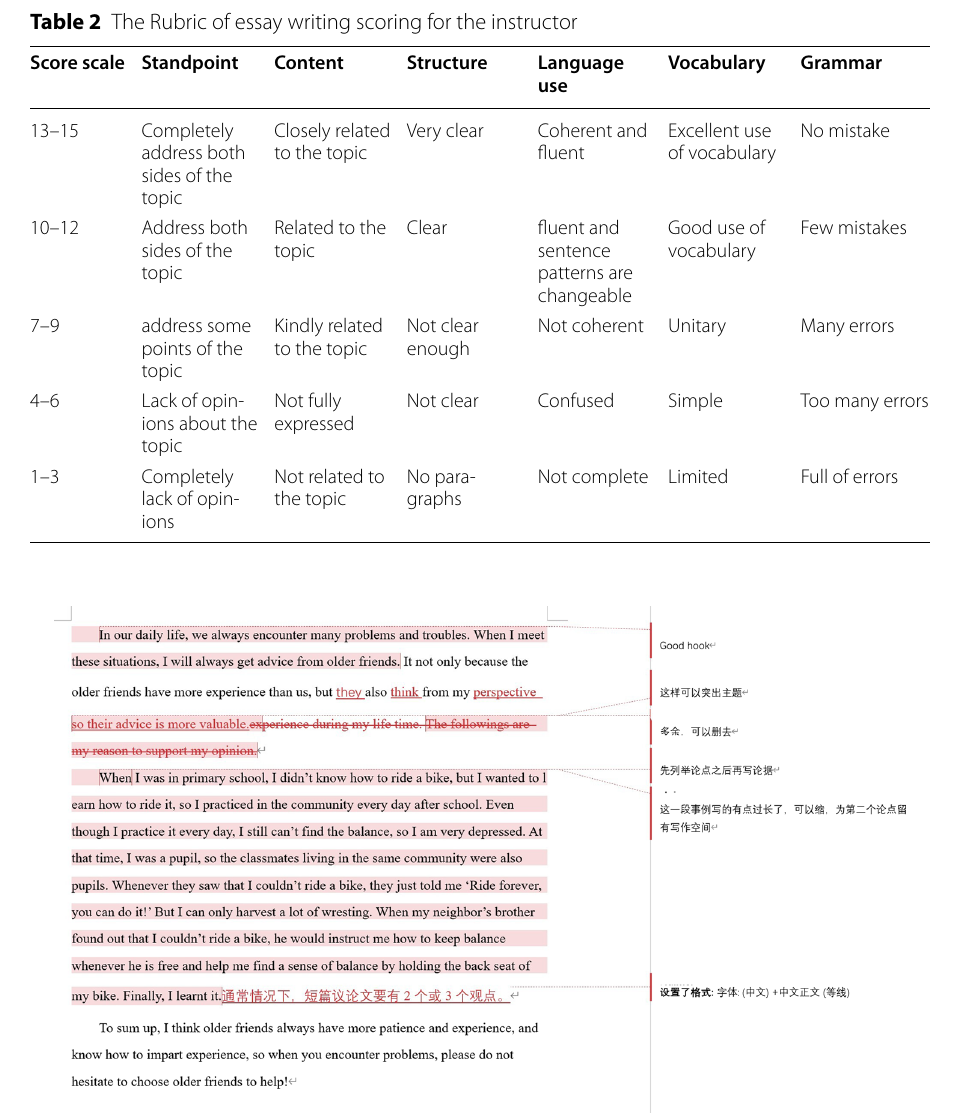
Fig. 1 The instructor’s feedback for one